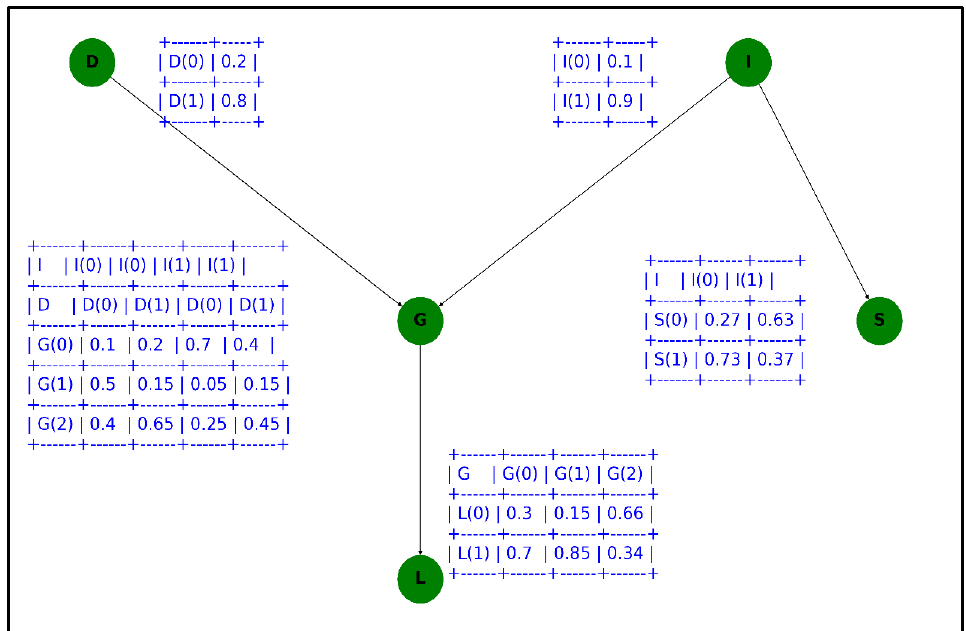
Figure 3. Example of Bayesian network.